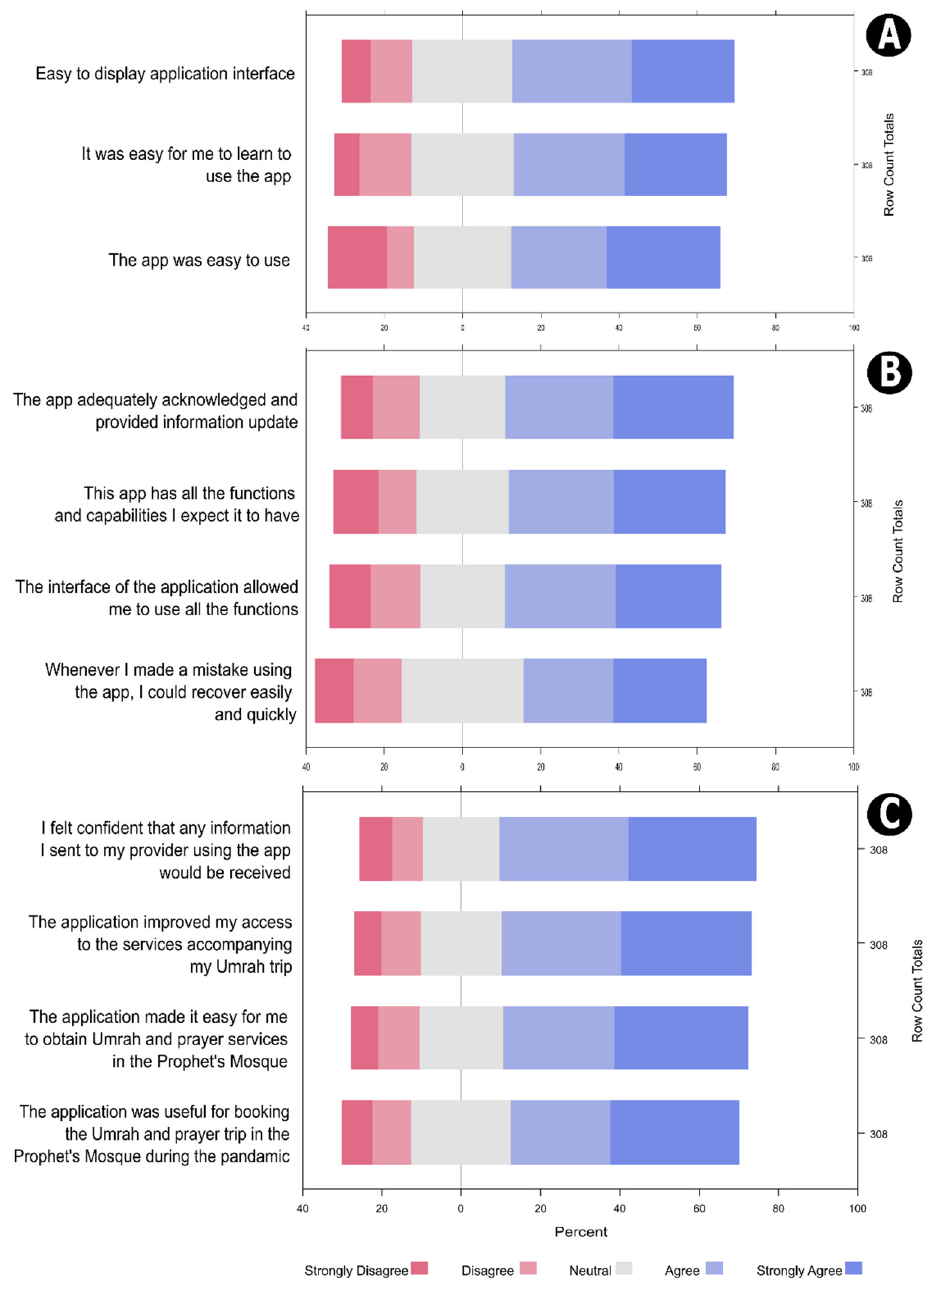
Figure 3. Participants responses regarding different Eatmarna application usability domains, including ease of use ( A ), system information arrangement ( B ) and usefulness ( C ).